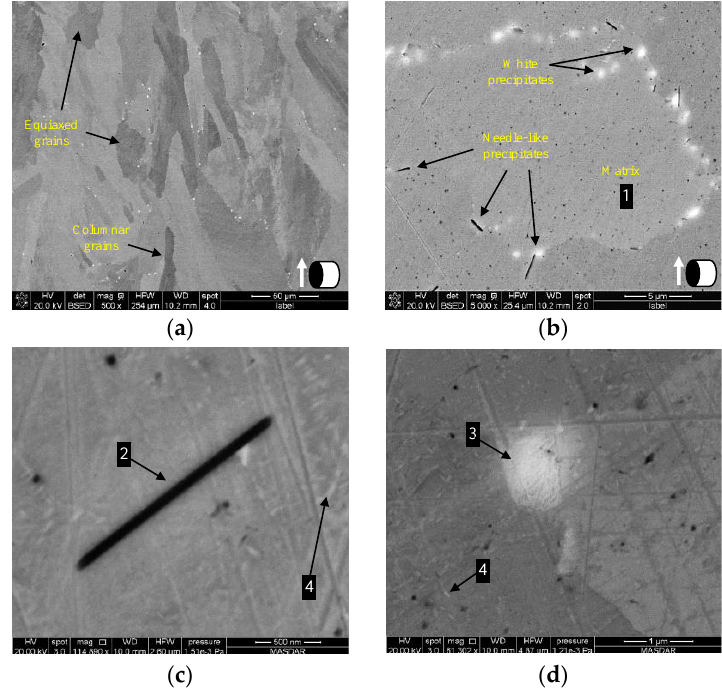
Figure 13. ( a ) Microstructure of a homogenized specimen; ( b ) different precipitates at the grain boundaries; ( c , d ) magnified images of δ-phase and MC-type carbide precipitates, respectively. The numbers correspond to the EDS spot analysis in Table 1.